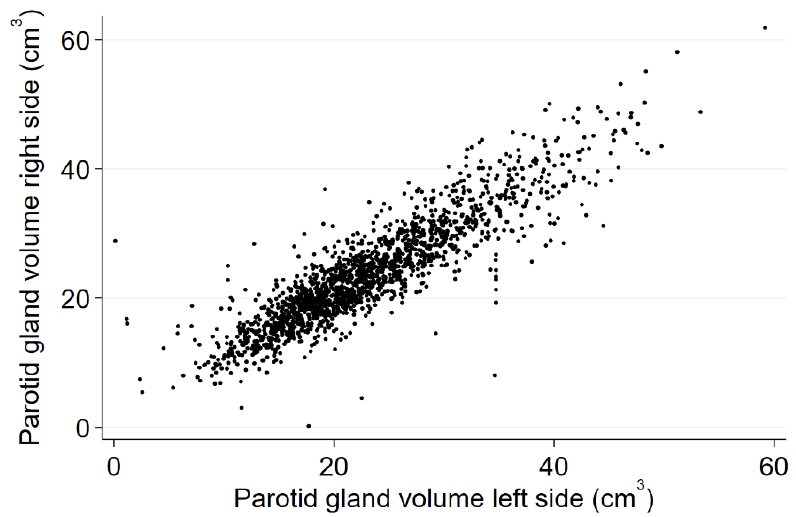
Figure 4. Distribution of volumes of left and right parotid glands.